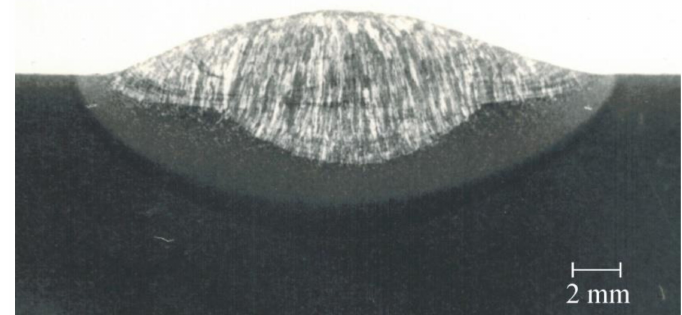
Figure 1. Metallographic specimen in the middle cross section.